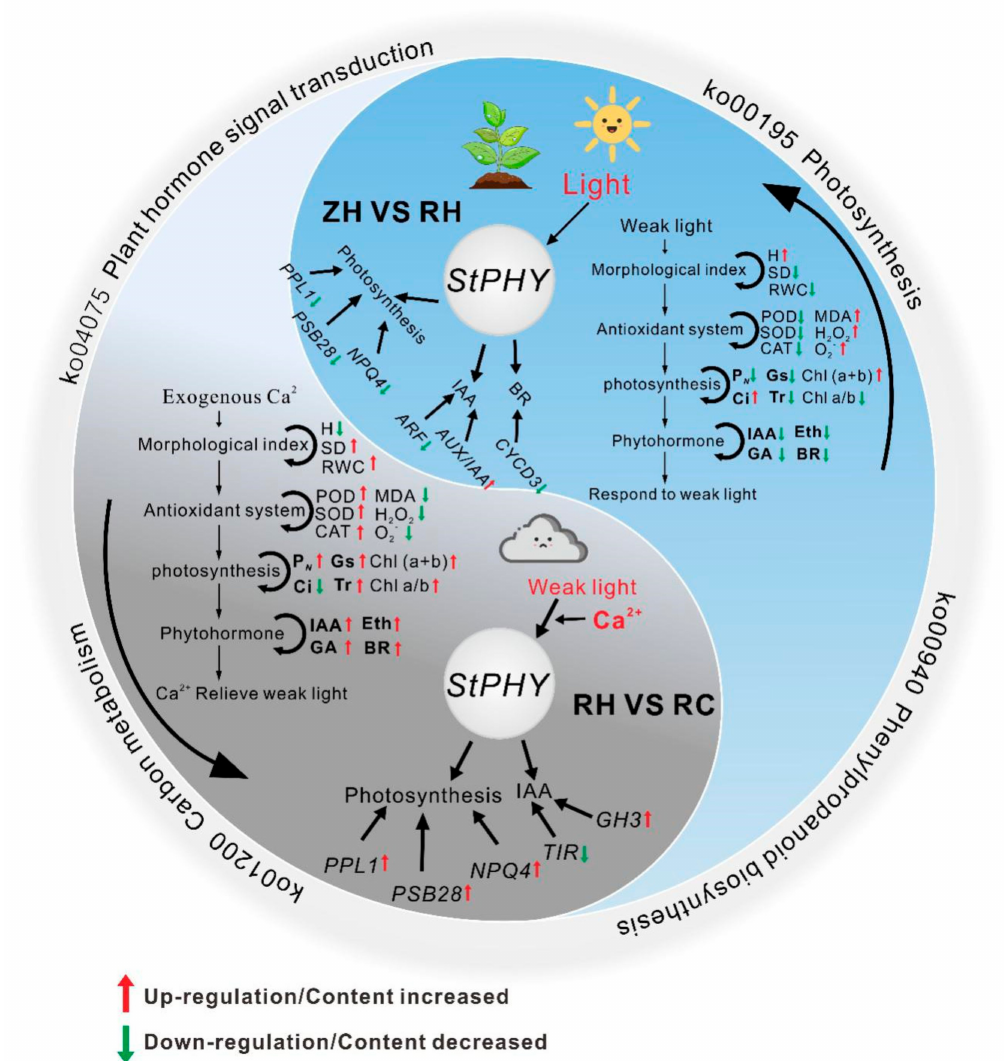
Figure 13. A putative model of a potato plant’s response to weak light and exogenous Ca 2 + . PHY responds to the light signal of the environment, induces a series of actions (ZH vs. RH) in weak light; exogenous Ca 2 + interfered in the light signal pathway, induces some opposite actions (RH vs. RC) and relieves partial injuries to the potato under weak light. Italics represent genes, the red arrows indicate up-regulation or increased content, and the green arrows indicate down-regulation or decreased